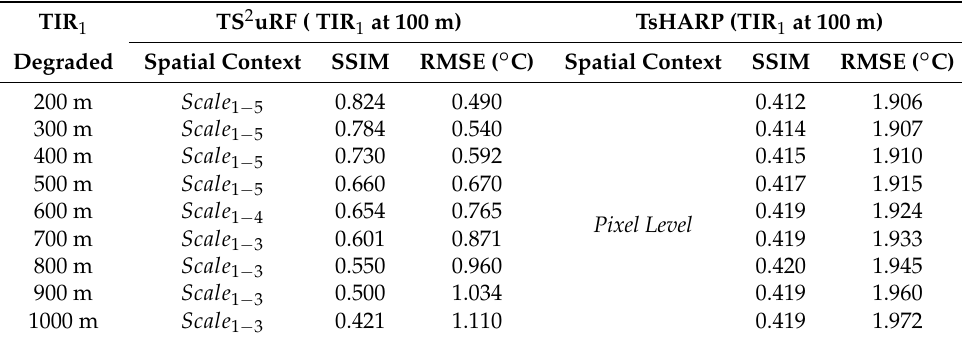
Table 3. Quality evaluation between reference image TIR 1 (100 m) and sharpened TIR 1 image obtained by TS 2 uRF and TsHARP using images degraded at different levels.